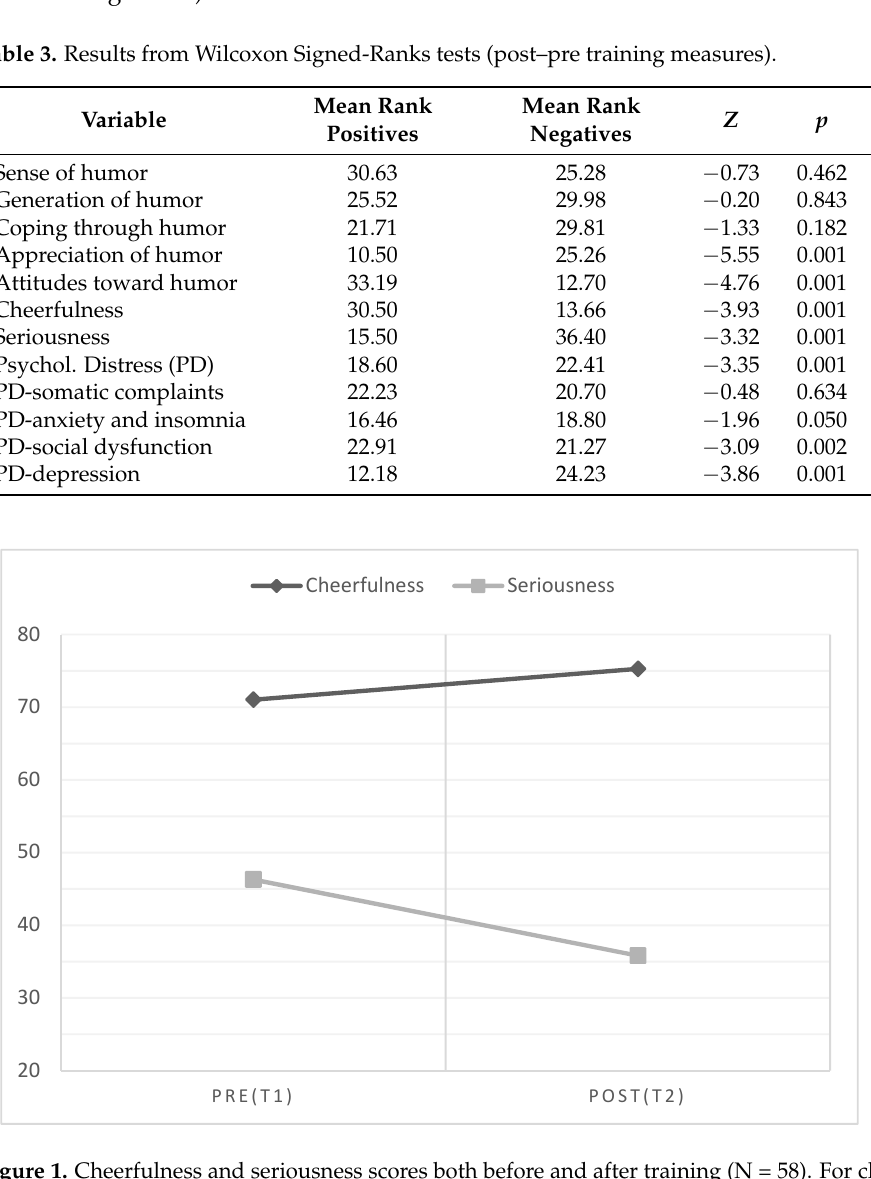
Figure 2. Scores for psychological distress dimensions both before and after training (N = 58). For clarity, the Y -axis shows mean scores (not mean ranks). 4. Discussion Healthcare workers use humor for different purposes, such as to relieve tension in difficult situations that challenge their professional abilities, be more benevolent with their own and others’ mistakes, manage patients’ negative emotions and fear and provide a high-quality service, maintain composure in grotesque situations, foster supportive re- lationships among coworkers [54–56], and recently, cope with the stress caused by work overload during the COVID-19 pandemic and the distress caused by the high risk of be- coming infected [57,58].